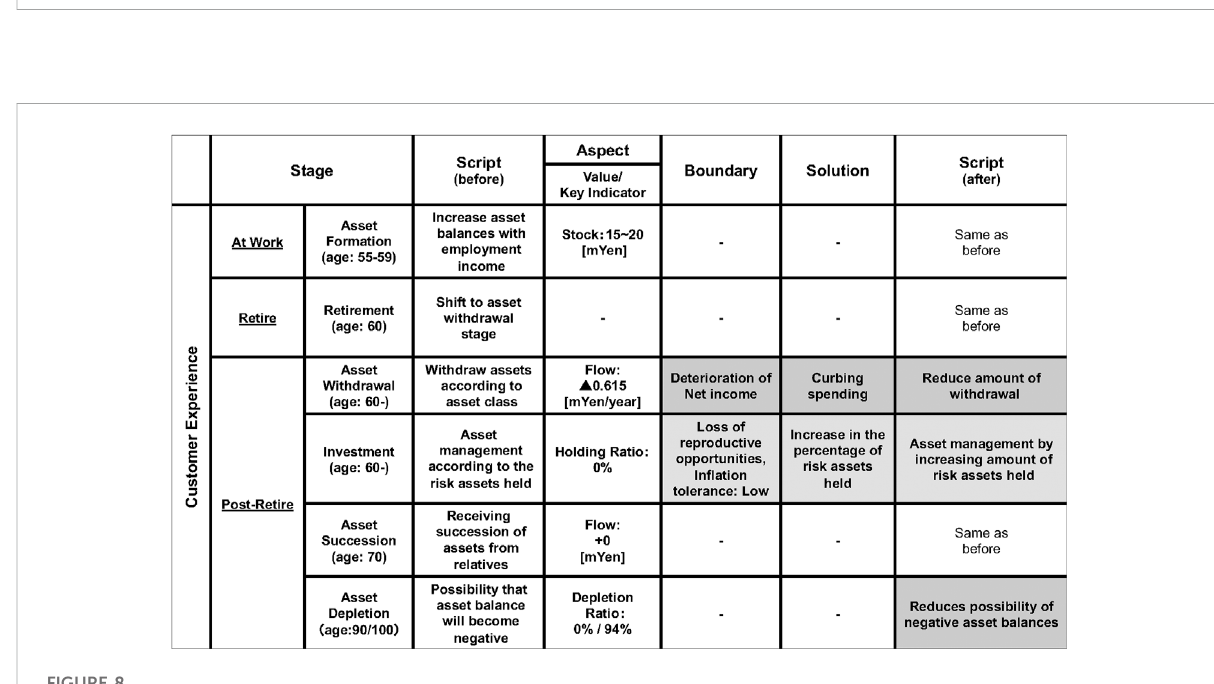
FIGURE 8 Simulation results described with SEBM (Customer type: